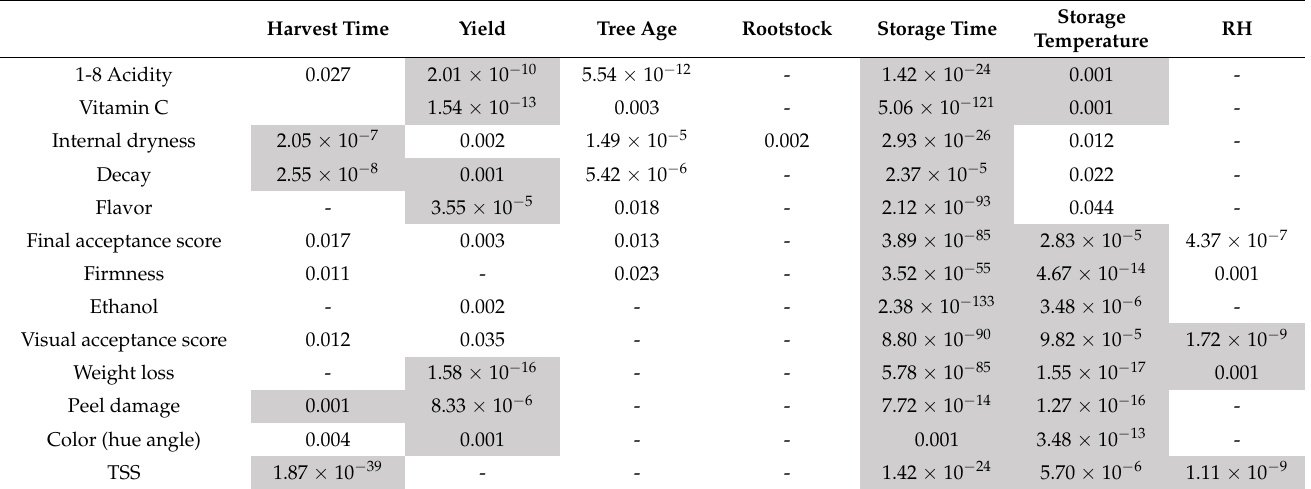
Table 2. Effects of different preharvest and postharvest features on the quality attributes of ‘Valencia’ oranges.